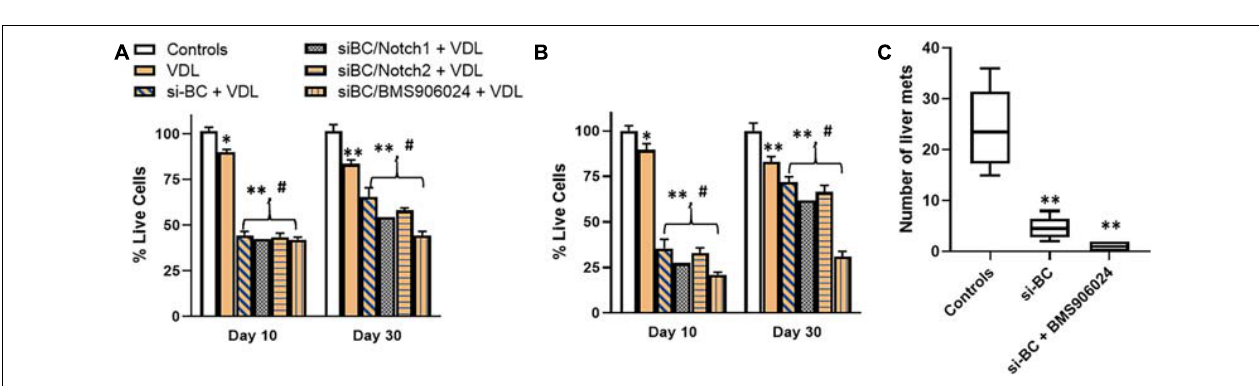
FIGURE 4 | Expression of β -catenin and alternate genes in T-ALL patients. Expression of (A) β -catenin (active dephosphorylated form). (B) Notch1. (C) Notch2. (D) c-Myc expression was evaluated, using ELISA, in T-ALL patients who had progressed on their therapy (Progressed, n = 28) and compared with those patients who were still responding (Responders, n = 24). P -values are mentioned for individual genes, as found significant.